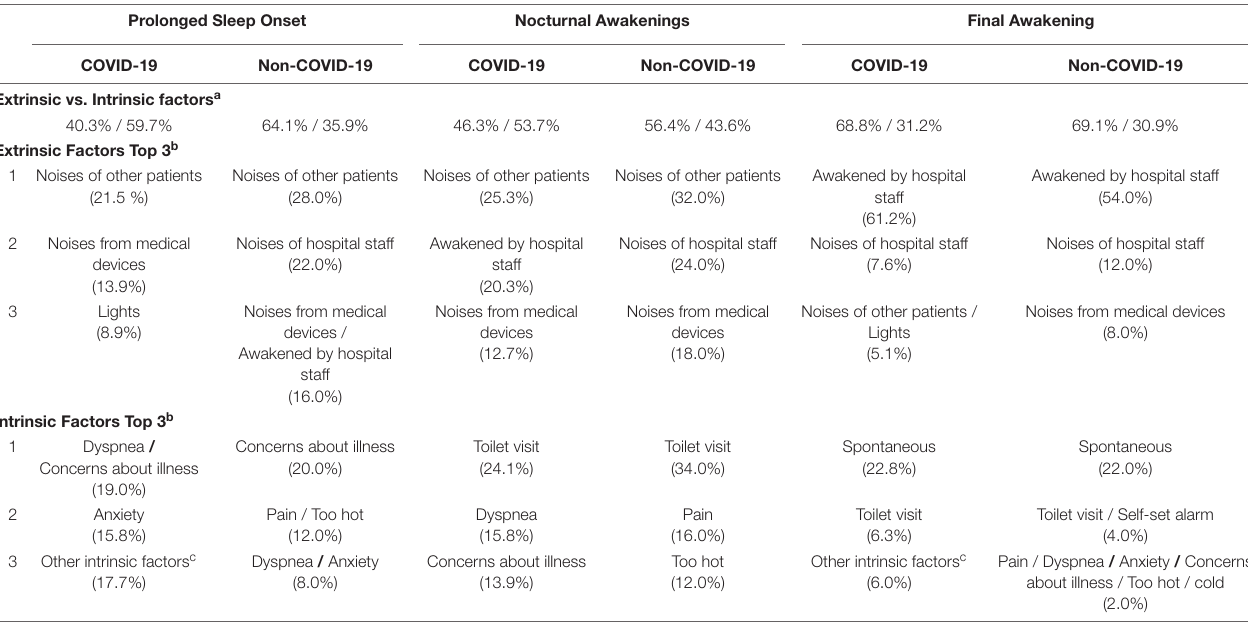
TABLE 4 | Sleep-Disturbing Factors COVID-19 and non-COVID-19 patients during the first